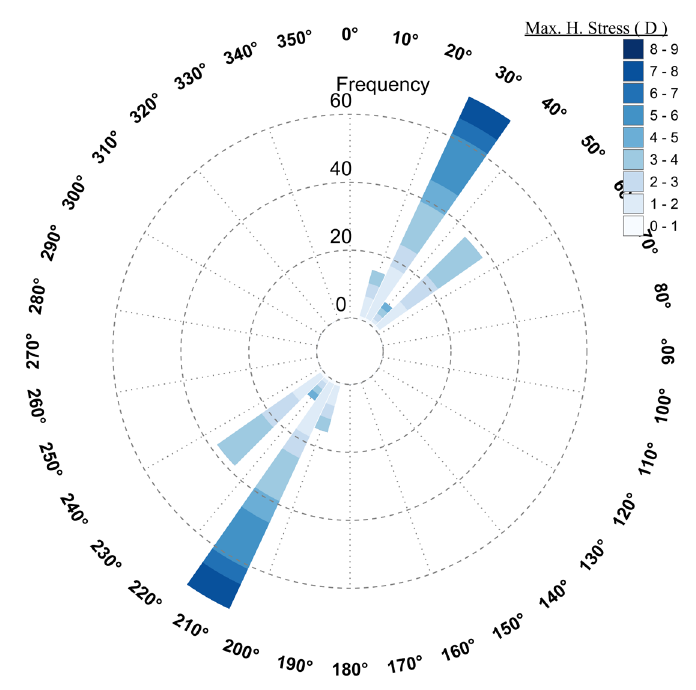
Figure 10. Wellbore-D wall maximum horizontal stress in the Azar oilfield occurred in azimuth 30° and 210° of NE-SW. This rose diagram result was made with windrose.xyz.